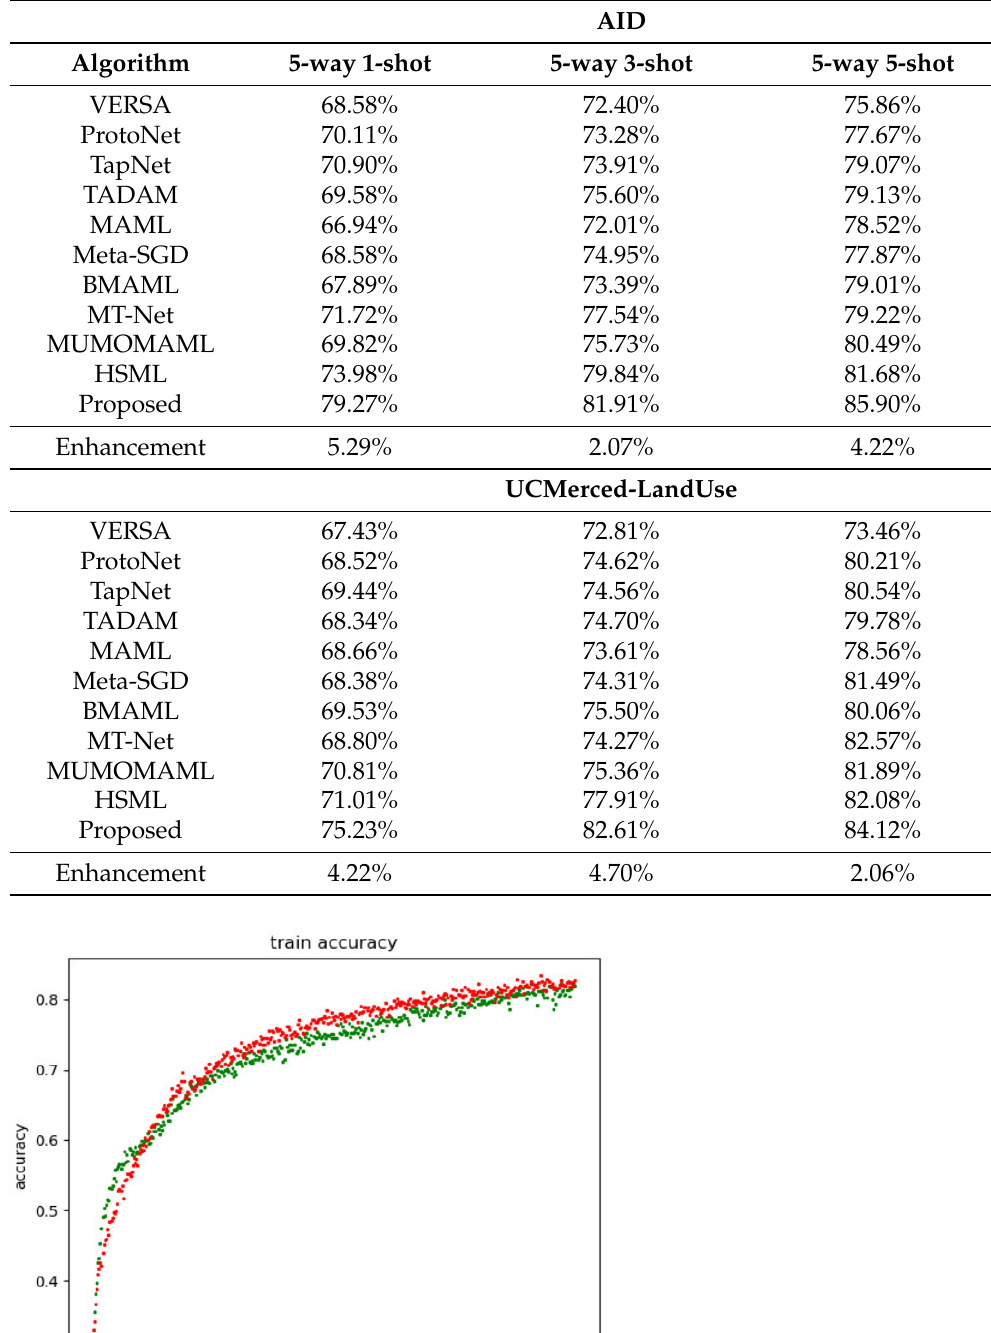
Table 3. Comparison of few-shot classification accuracy of task-covariant learning, task-invariant, and task-heterogeneous methods on AID and UCMerced-LandUse datasets.